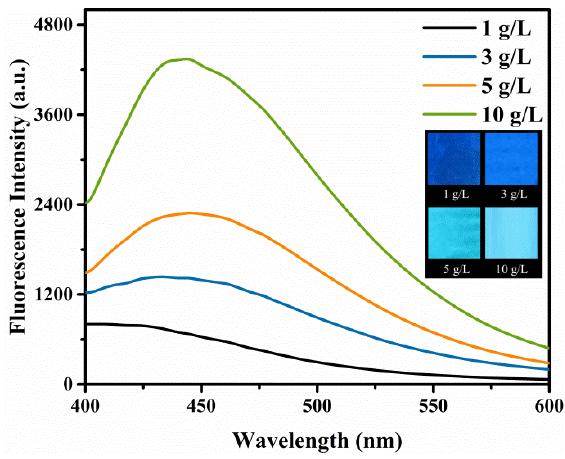
Figure 4. Fluorescence emission spectra of the hydrogel with different embedded PEI-CdS QD contents in the range of 1 g/L to 10